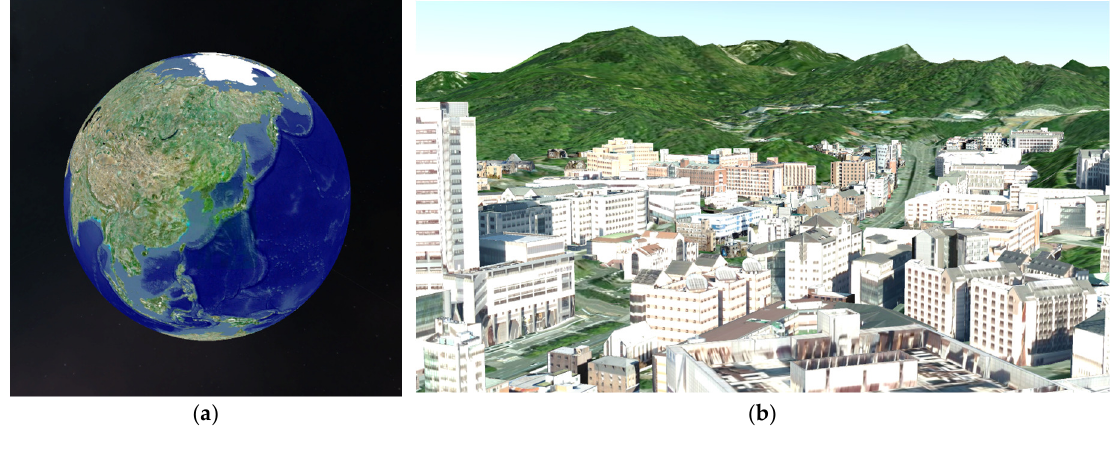
Figure 12. Examples of implemented planetary-scale UDT model visualization: ( a ) Earth visualized in planetary-scale; ( b ) close-up camera shot of the surface of Earth, rendering 3D terrain, buildings, and road layers.